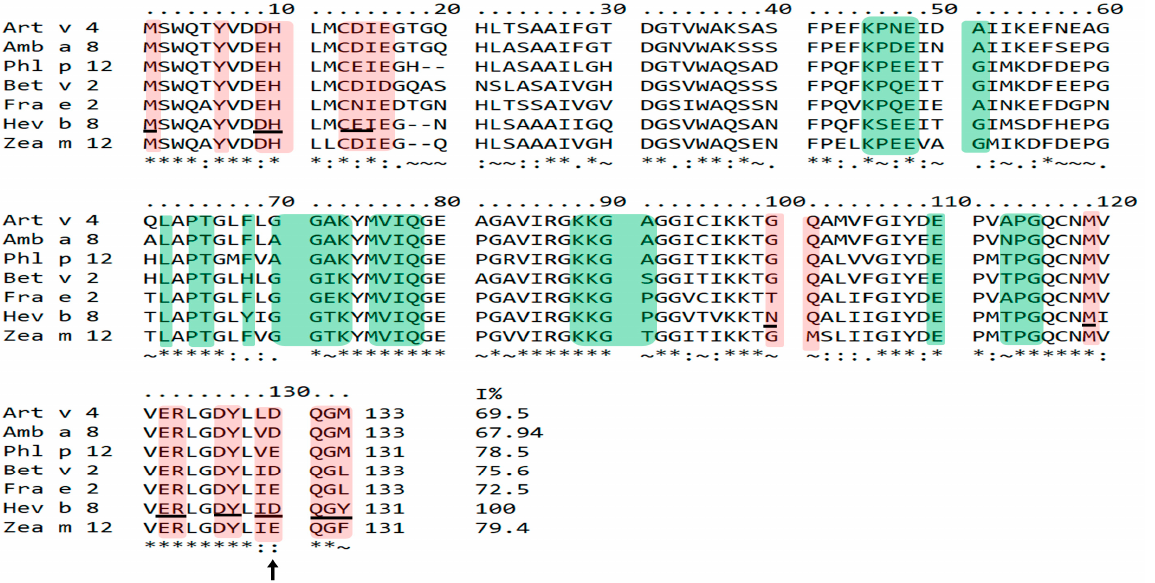
Figure 4. Mapping recognition sites of mAbs 2D10 and 1B4 in plant profilins’ sequences . The theo- retical epitopes recognized by these two mAbs were previously determined by modeling their Fvs and docked with rHev b 8 [13]. Residues corresponding to mAb 2D10 recognition site are shaded in pink, while those conforming to the mAb 1B4 recognition site are shaded in green. The profilin sequences correspond to Amb a 8— Ambrosia artemisiifolia (ragweed), Phl p 12— Phleum pratense (Timothy grass), Bet v 2— Betula verrucosa (birch), Fra e 2— Fraxinus excelsior (ash), Hev b 8— Hevea brasilensis (latex), and Zea m 12— Zea mays (maize). The black arrow shows the D128 residue recog- nized by the mAb 2D10. This residue is also recognized by the 2F5/IgE on Hev b 8 (underlined in black), as reported by García-Ramírez et al. 2022 [12]. An asterisk ( * ) indicates fully conserved resi- dues, a colon ( : ) indicates similar properties, a period ( . ) indicates weakly similar properties, and a tilde ( ~ ) indicates different properties.